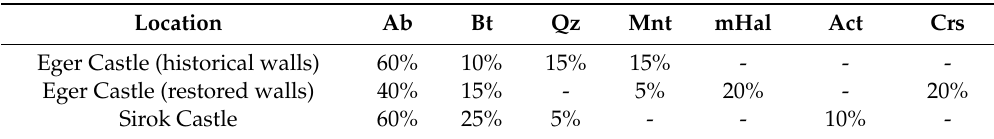
Figure 3. Thin-section photomicrographs in plane- and cross-polarized light of the studied tu ff s, at the same magnification, with the rock components listed in order of abundance (NCC = non-crystalline components and lithoclasts; RFM = rock-forming minerals; AM = accessory minerals). Table 2. Semi-quantitative composition of the studied tu ff s calculated from the relevant XRD patterns considering the major mineral phases (Ab = albite; Act = actinolite; Bt = biotite; Crs = cristobalite; mHal = meta-halloysite; Mnt = montmorillonite; Qz =